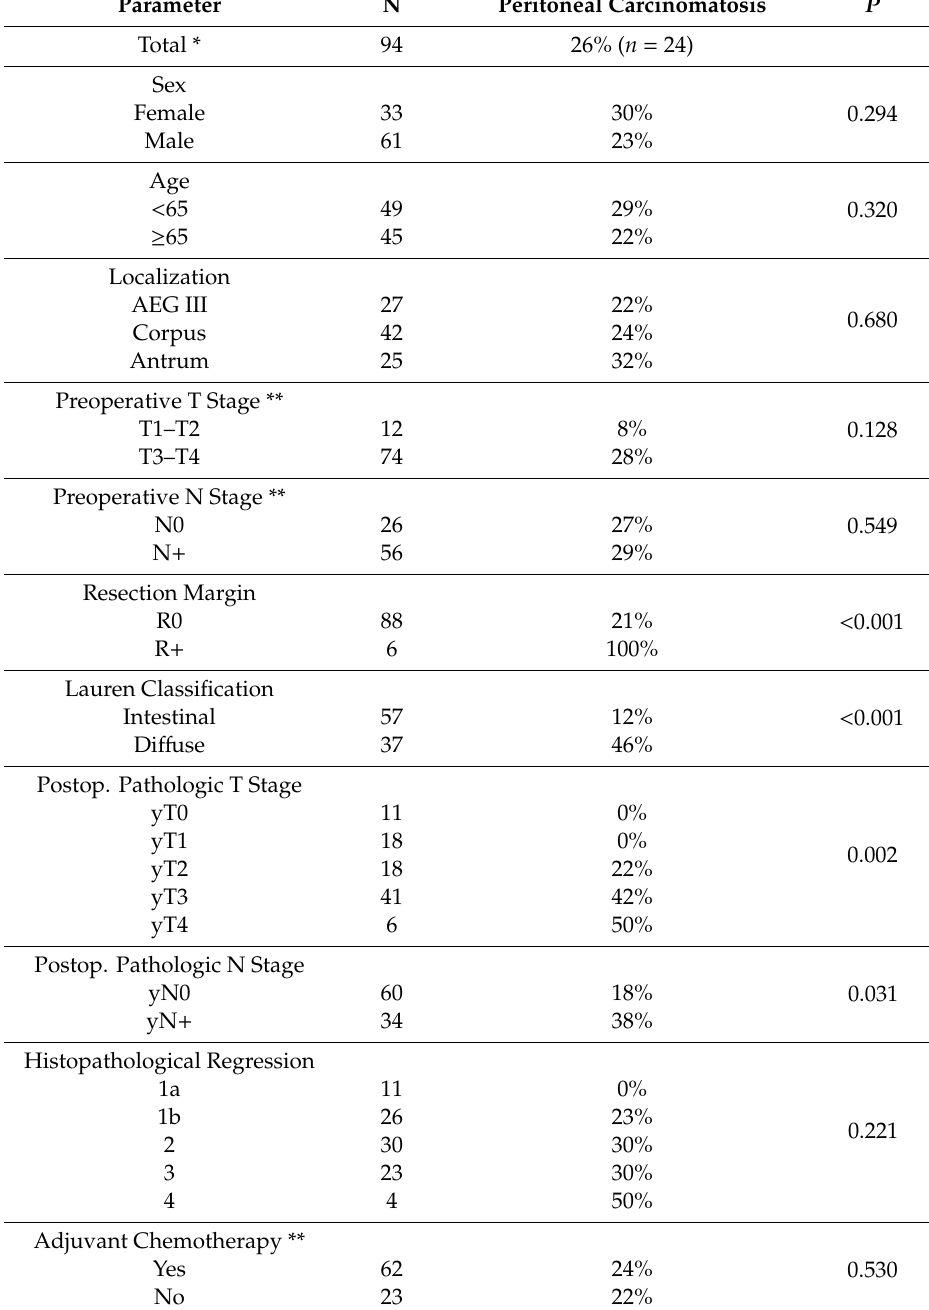
Table 3. Risk factors for development of peritoneal carcinomatosis after FLOT and chemotherapy for gastric cancer (patients with intraoperative metastasis ( n = 3) were